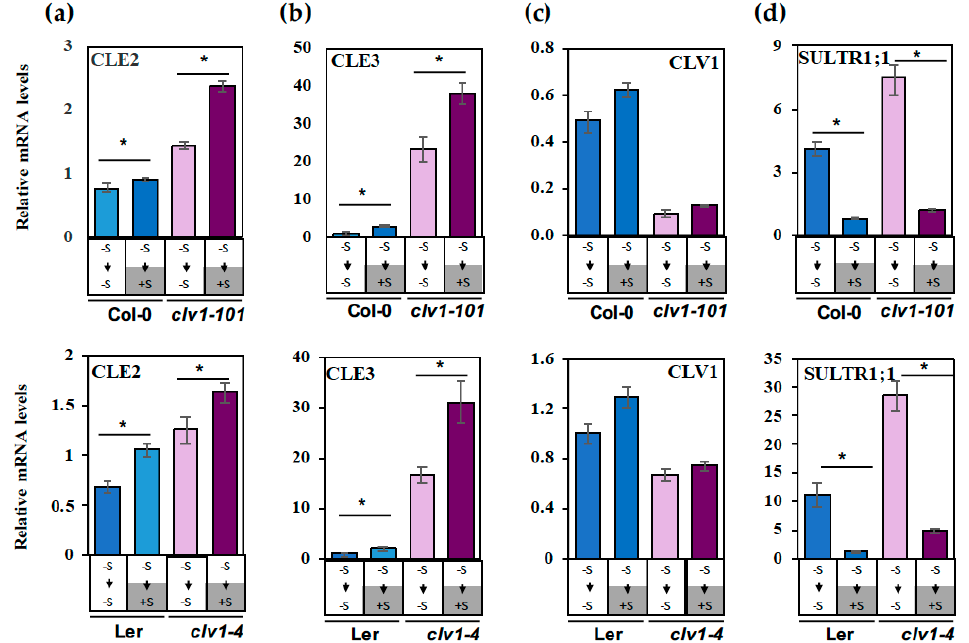
Figure 5. Regulation of CLE2 and CLE3 transcript levels by S deprivation and sulfate supply. Wild-type (Col-0 and L er ) and clv1 mutant lines ( clv1-101 and clv1-4 ) were grown vertically on –S (15 µ M sulfate) medium for 7 days and then transferred to –S medium or + S medium to be grown subsequently for 3 days. The mRNA levels of ( a ) CLE2, ( b ) CLE3, ( c ) CLV1 and ( d ) SULTR1;1 in roots at Day 10 (i.e., Day 7 + 3) were determined by real-time PCR. Roots of wild-type plants grown on the + S medium for 10 days were used as reference samples for relative quantifications. Actin 2 and Ef1 α were used as internal controls. Mean values ( ± SE) of 4 biological replicates with 8 plants for each replicate were calculated using two internal controls. Asterisks indicate statistically significant di ff erences ( P < 0.05) between gene expression on –S and + S treatment. The S conditions and the order of transfers are shown by white and dark grey bars and arrows below the graph.